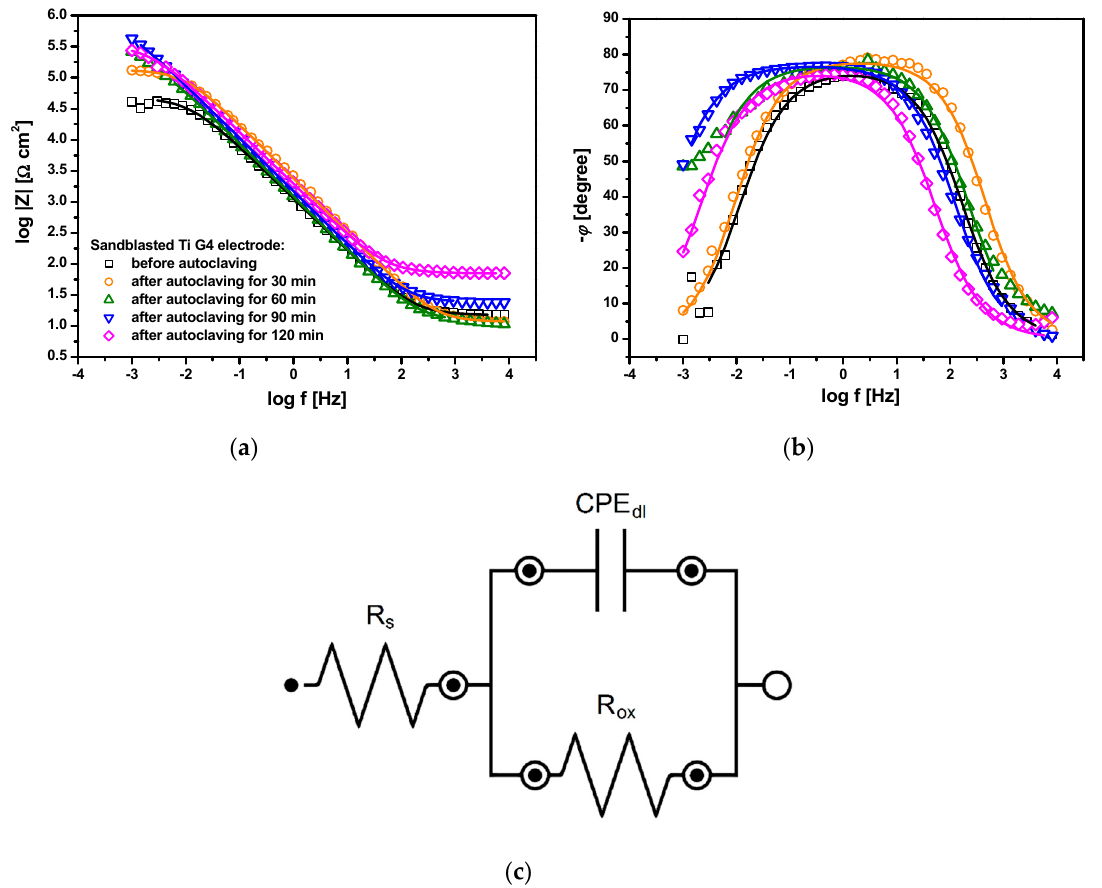
Figure 10. Bode diagrams obtained for the sandblasted Ti G4 electrode before and after autoclaving at E cor in ASS at 37 °C: ( a ) Magnitude; ( b ) Phase angle; ( c ) Equivalent electrical circuit for the corrosion used to model the EIS data. Symbols are experimental data and continuous lines are CNLS fit.